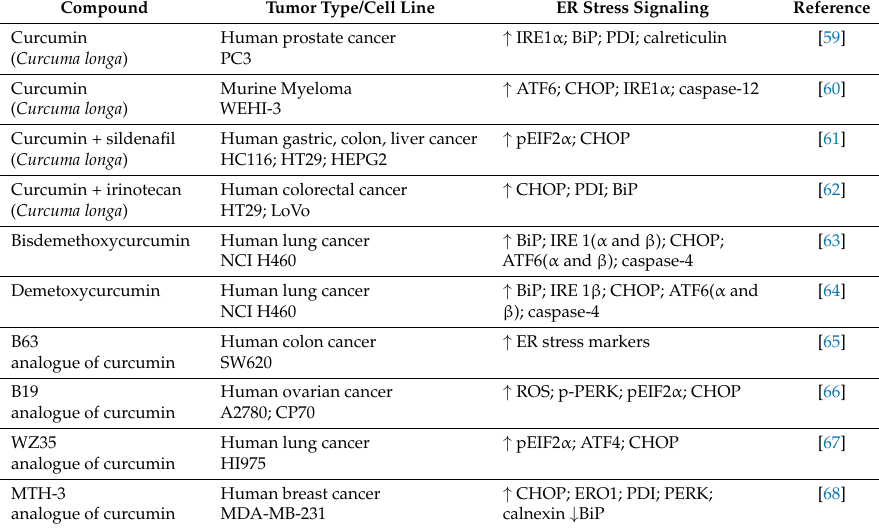
Table 1. Curcumin and its analogues with ER stress-mediated anticancer